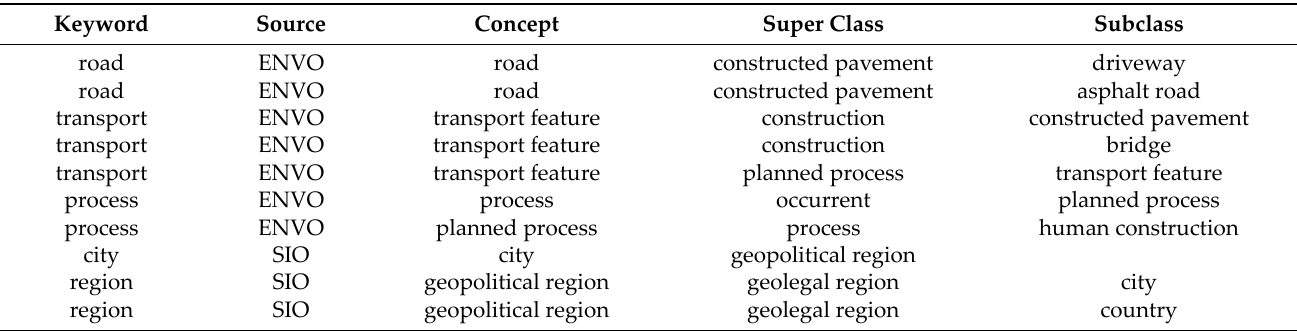
Table 4. Concepts matched from existing